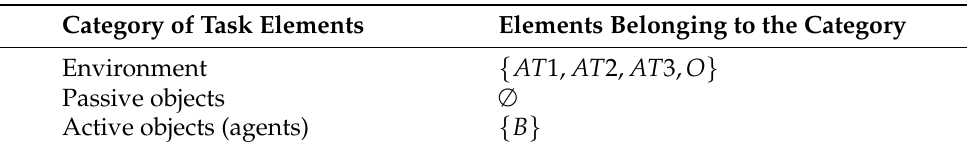
Table 15. Categorization of task elements for the first example. Note that this produces an incorrect model because the moved object is considered an environment element.